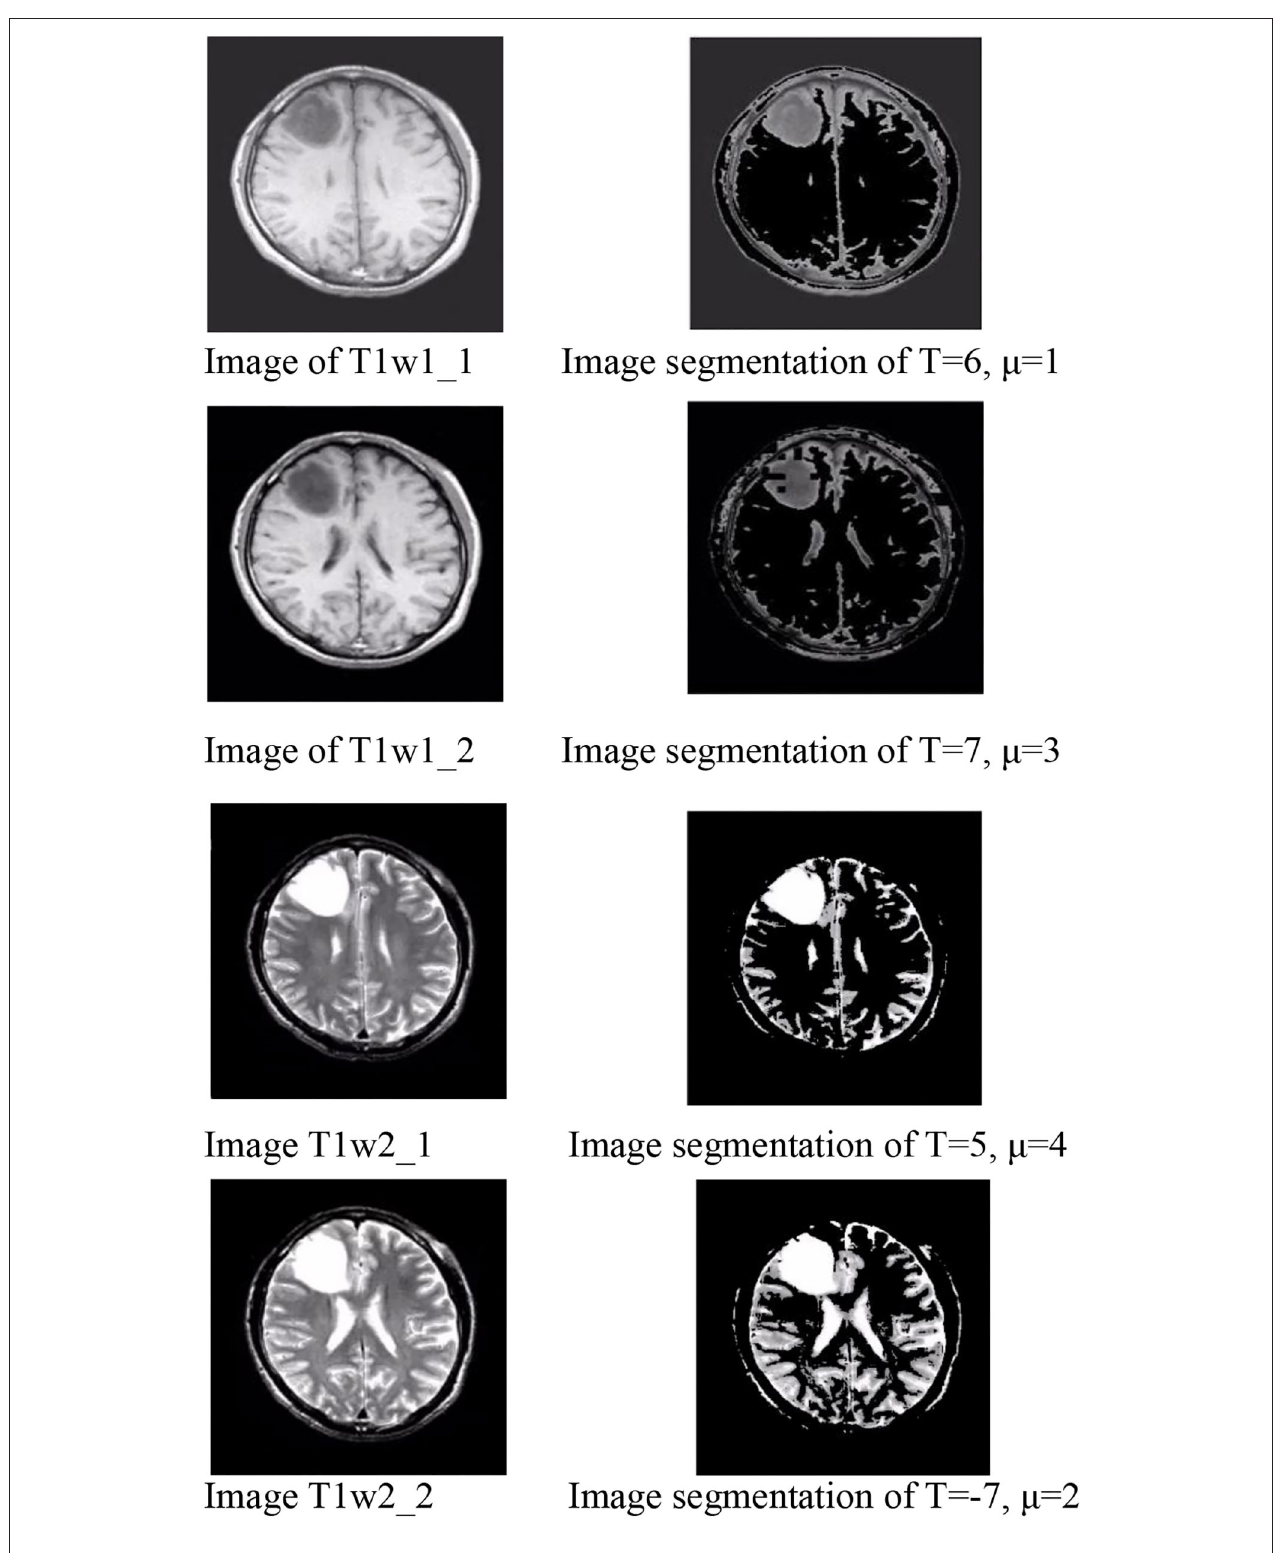
FIGURE 9 | Image of group 1 and its best value image